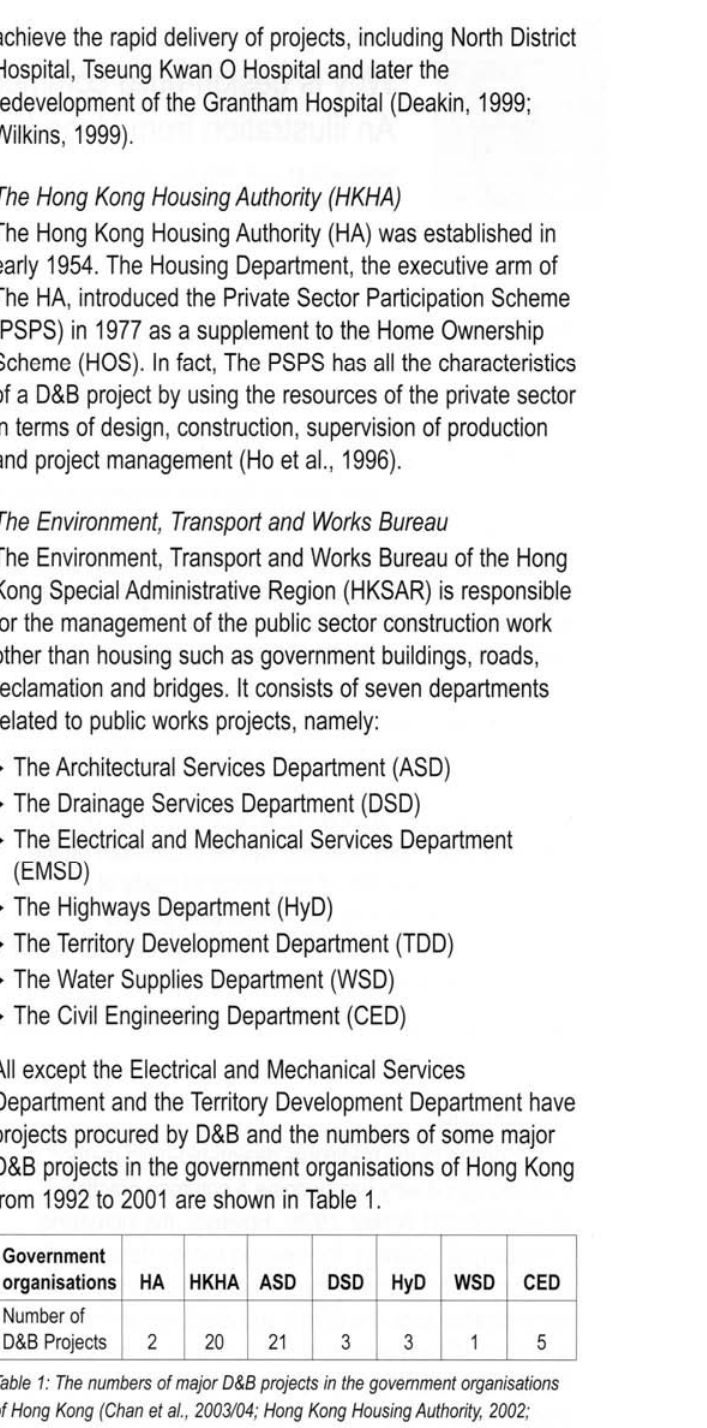
Table 1: The numbers of major D&B projects in the government organisations of Hong Kong (Chan et al., 2003104; Hong Kong Housing Authority, 2002; Environment, Transport and Works Bureau,